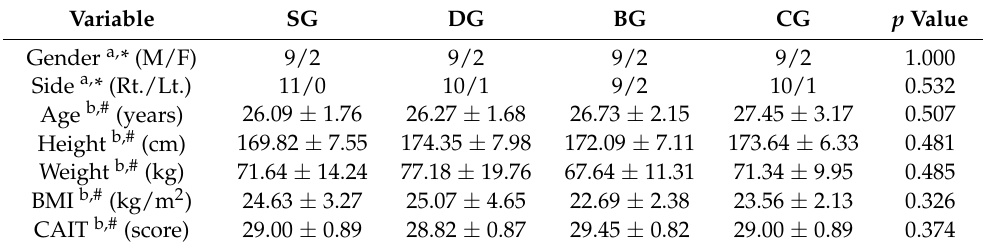
Table 1. Participants’ general characteristics.